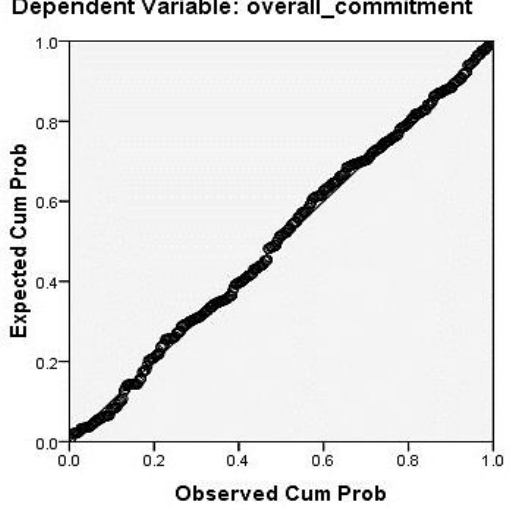
Figure 2. Normality of standardized